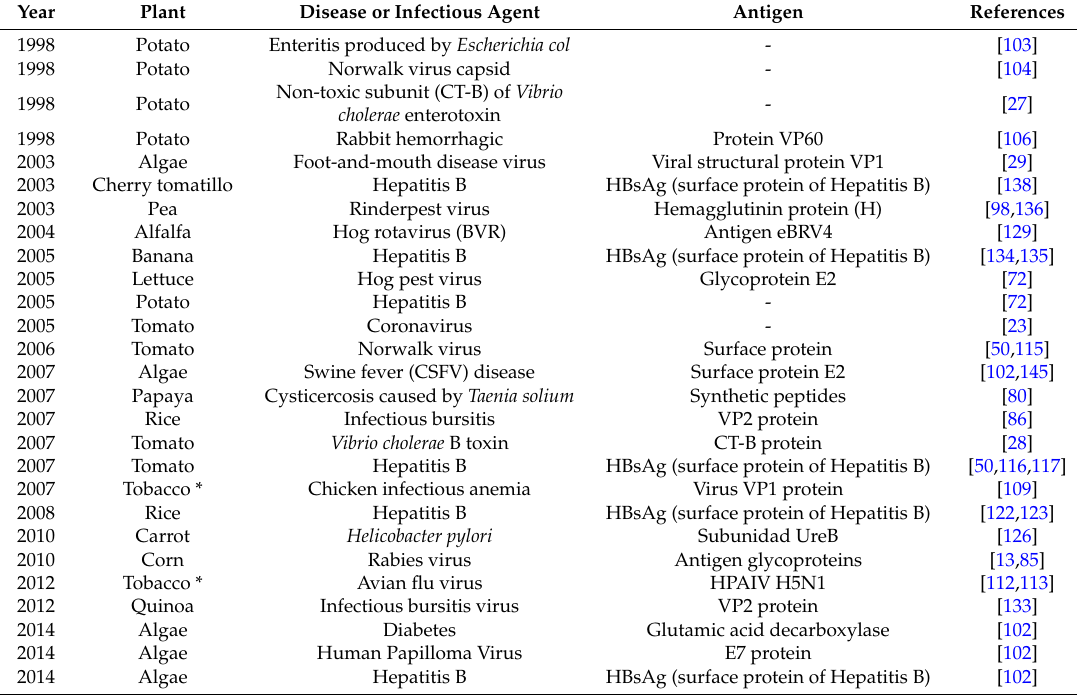
Table 2. List of plants studied as edible vaccines. The checklist is organized by year, since 1998 until